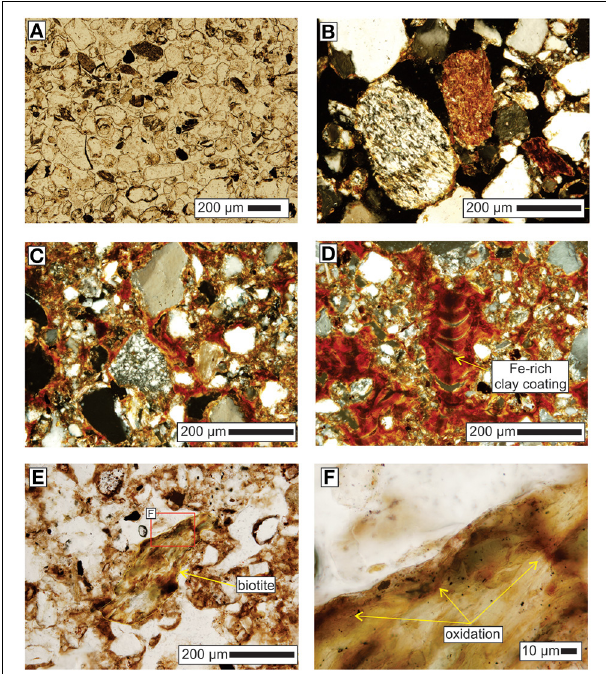
FIGURE 4 | Photomicrographs from T2 alluvial soils showing range of development. All images are oriented with vertical up toward the image top. XPL, cross-polarized light; PPL, plane-polarized light. (A) parent material from base of T2 showing quartz, mica, and rock fragments (PPL). (B) Sand grains in a porous matrix with little to no illuviated clay; from Ab horizon, ∼ 76cm below surface (XPL). (C) Fe-rich clay coatings along sand grains in Bwb horizon, ∼ 236cm below surface (XPL). (D) Fe-rich clay coating along channel pore in Btb horizon, ∼ 380cm below surface (XPL). (E) Weathered biotite grain with oxidized zones (oxidized magnetite, maghemite?) (PPL). (F) Magnified view of C showing evidence of oxidation of Fe(II) to Fe(III), possibly maghemite (PPL).